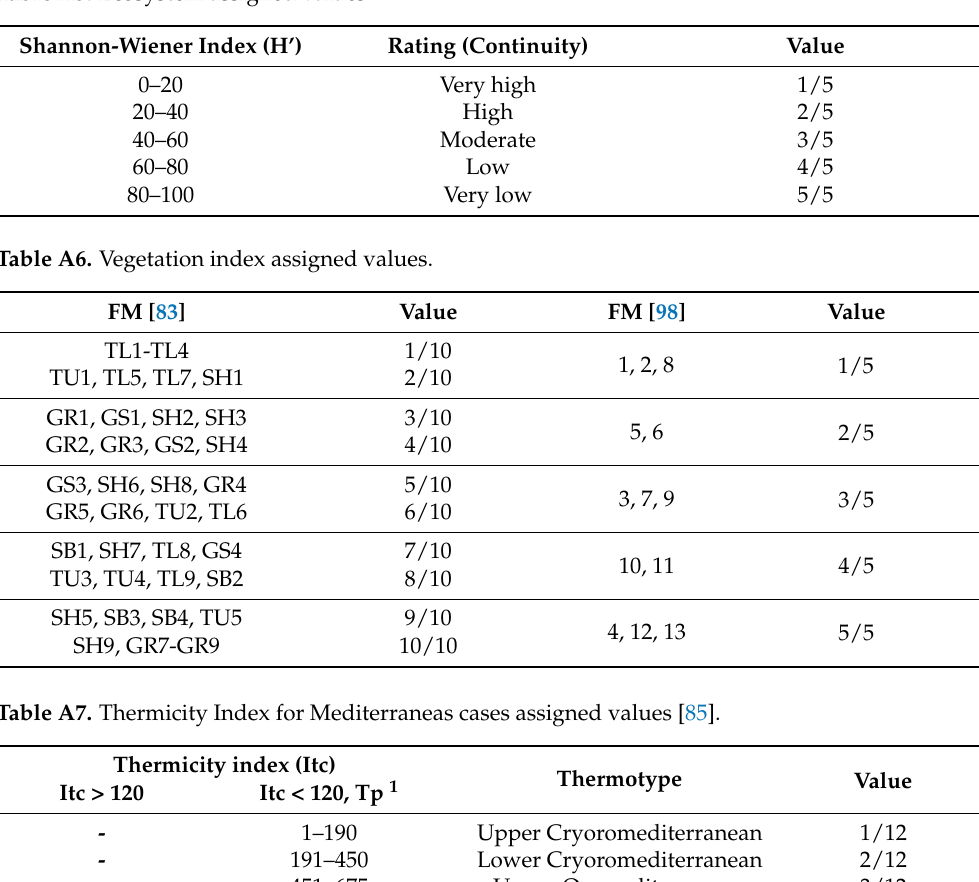
Table A5. Ecosystem assigned values.